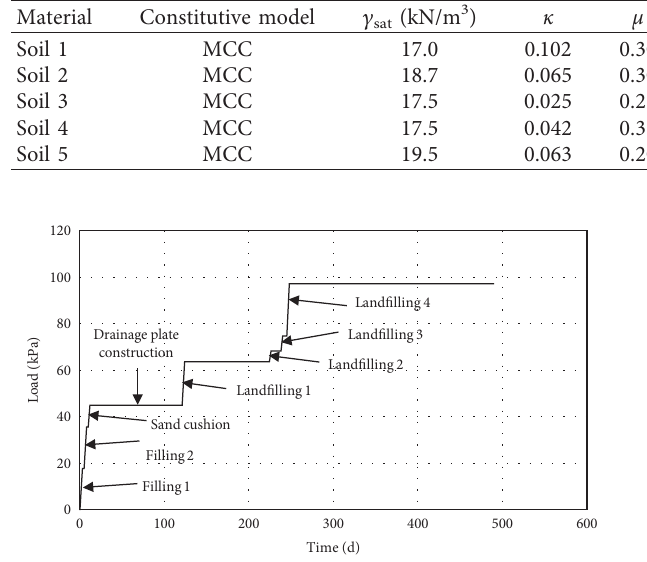
Figure 3: Loading process